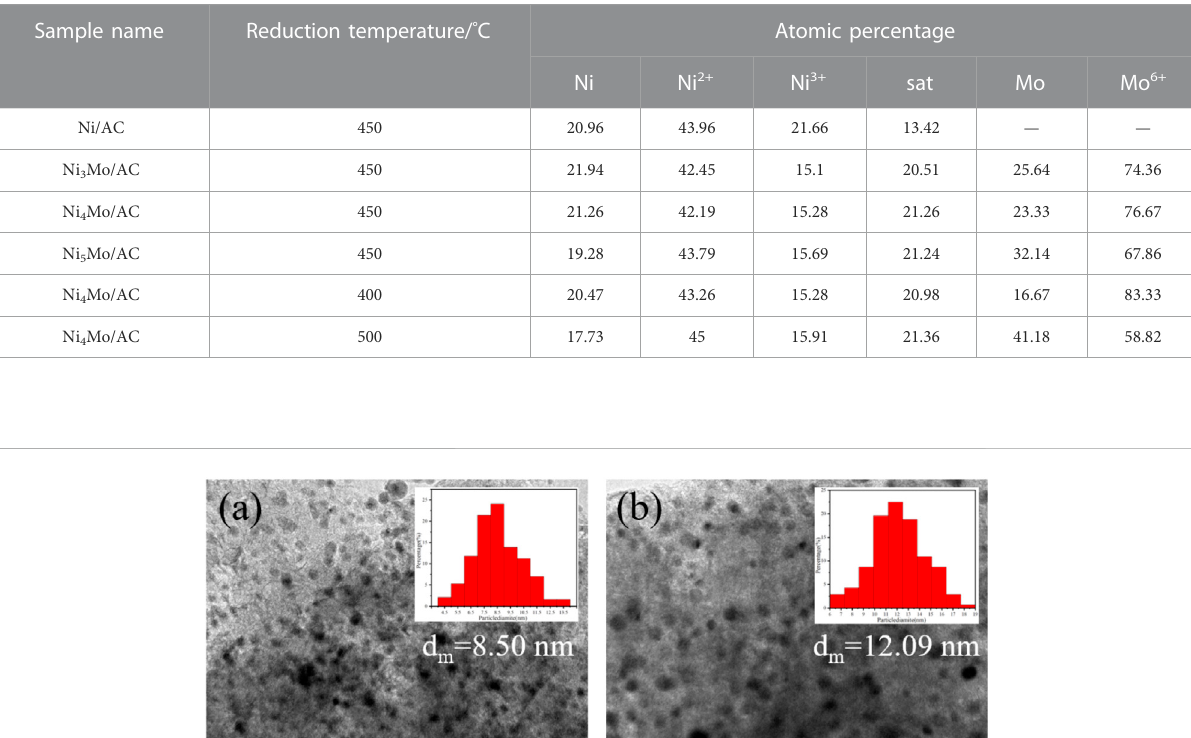
TABLE 3 XPS data of samples.